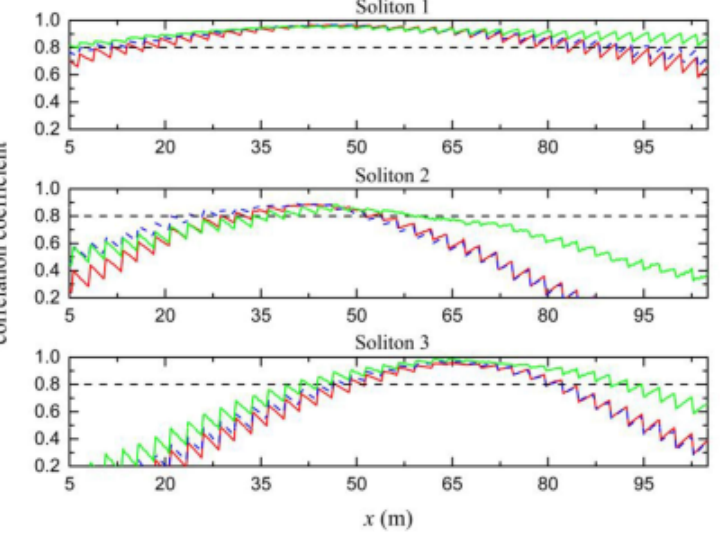
Figure 10. Correlation coefficient between three wave groups and theoretical solitons. The red solid lines correspond to the simulation with only linear effects ( M = 1). The blue dashed lines correspond to the simulation with second harmonic effects ( M = 2). The green solid lines correspond to the simulation with third-order nonlinear effects ( M = 3). The black dashed lines correspond to the 80%